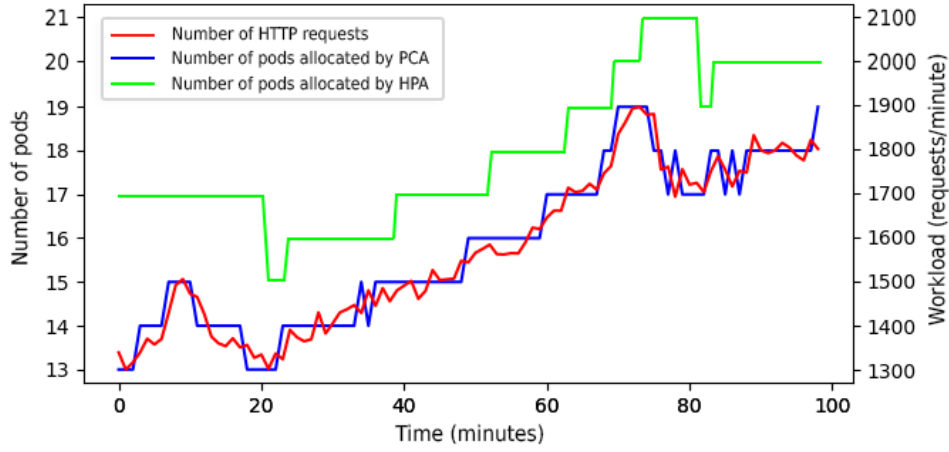
Figure 18. Evaluation of proposed auto-scaler in the real